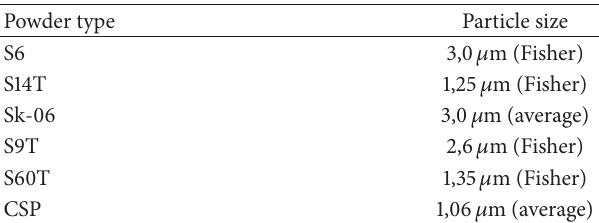
Table 1: Powder types and their particle